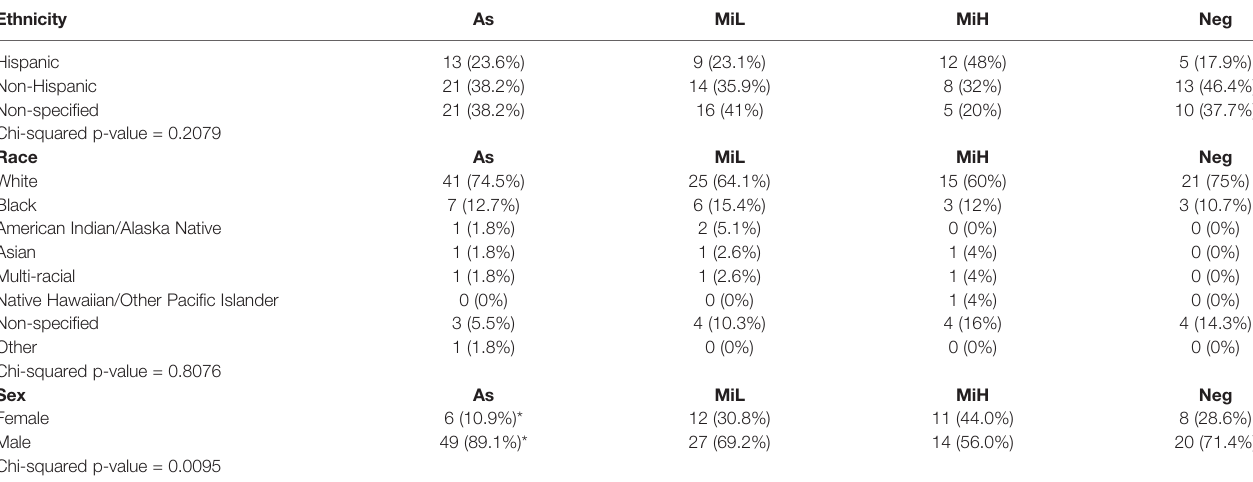
TABLE 2 | Contingency table showing the distribution of ethnicity, race and sex in As, MiL, MiH and Neg groups. Ethnicity As MiL MiH Neg